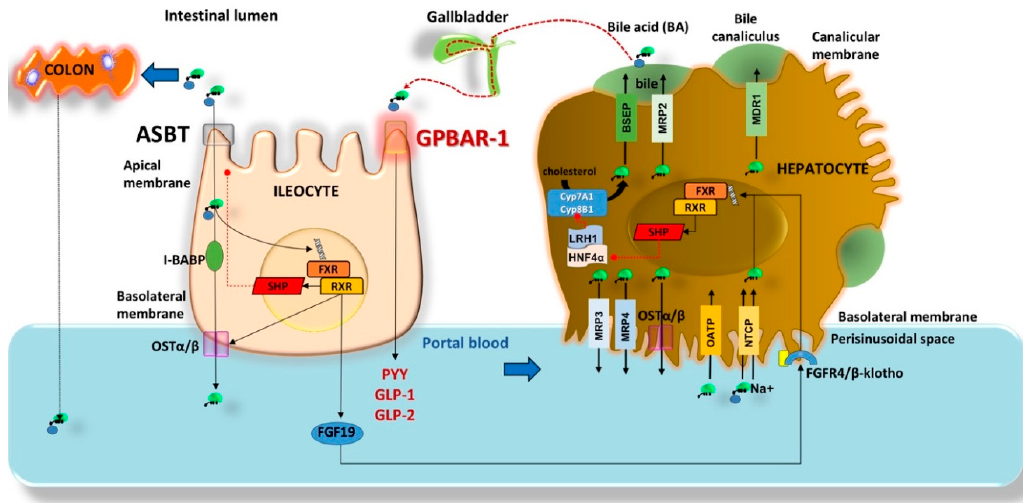
Figure 2. Mechanisms governing bile acid (BA) enterohepatic circulation. In the liver BA undergo secretion into the perisinusoidal space by multidrug resistance proteins (MRP3, MRP4), and heterodimeric organic solute transporter (OST α / β ). Uptake is via organic anion transporting polypeptides (OATP) and Na+ − taurocholate cotransporting polypeptide (NCTP). In the bile canaliculus, BA are secreted by bile acid export pump (BSEP) [21], MRP2, and multidrug resistance protein 1 (MDR1), and stored in the gallbladder upon neurohormonal-mediated contraction. In the terminal ileum, BA uptake occurs across the apical sodium dependent bile acid transporter (ASBT), the intracellular transport requires the intestinal BA binding protein (I-BABP); the secretion into the portal vein requires OST α / β . BA signal the nuclear receptor Farnesoid X receptor (FXR) and retinoid X receptor (RXR) with effects on the small heterodimer partner (SHP), OST α / β , and synthesis of the human enterokine fibroblast growth factor 19 (FGF19). BA also signal the ileal membrane receptor GPBAR-1 governing the secretion of peptide YY (PYY), glucagon-like peptide 1 (GLP-1) and glucagon-like peptide 2 (GLP-2) with metabolic effects (see text) [9,22]. Reabsorbed BA undergo peripheral spill over into the systemic circulation by about 10 – 50% [23]. About 15% of BA enter the colon for biotransformation into secondary BA and passive reabsorption. BA re-entering the liver can interact with GPBAR-1 in Kupffer cells and FXR-RXR-SHP (hepatocytes) [24] pathway which inhibits the activity of hepatocyte nuclear factor 4 (HNF4 α ) and liver-related homologue-1 (LRH1), resulting in inhibited expression of target genes governing BA synthesis ( CYP7A1 and CYP8B1 ) and fatty acid synthesis. At low concentrations of BA, however, LRH-1 acts with LXR to trigger BA synthesis [25,26,27]. The circulating BA undergo renal uptake by the ASBT in the proximal tubules. MRP 2, 3, 4 transporters regulate glomerular filtration of BA [28]. The dashed red lines (----- • ) indicate inhibition.